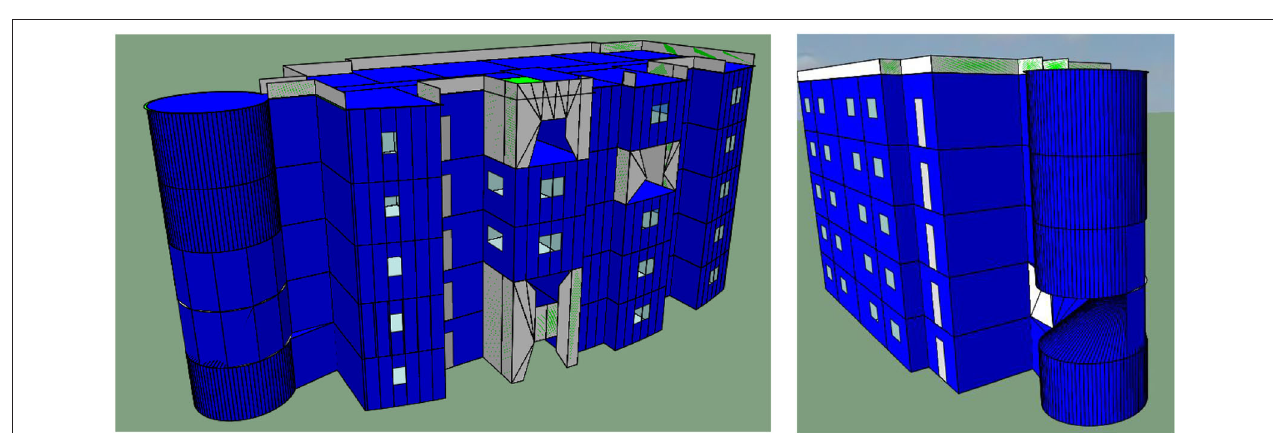
FIGURE 13 | The modified building shape after being received by IES-ve.